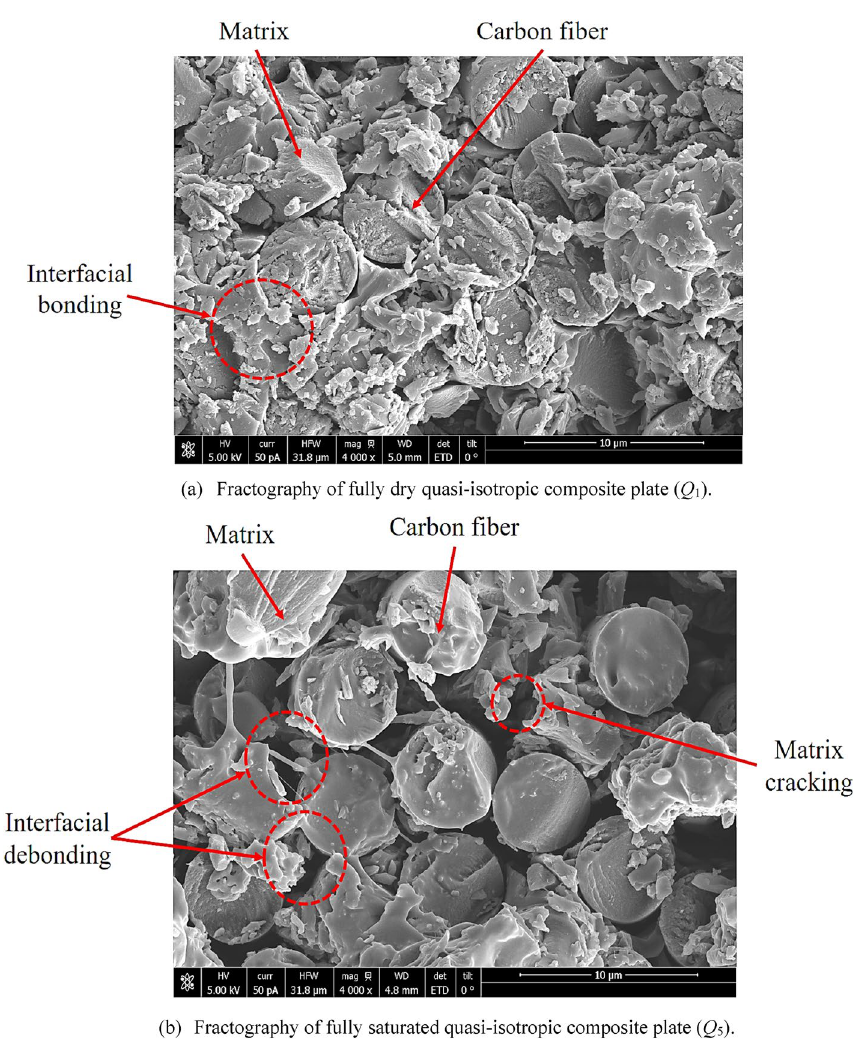
Figure 2. SEM fractographies for ( a ) fully dry and ( b ) fully saturation quasi-isotropic composite